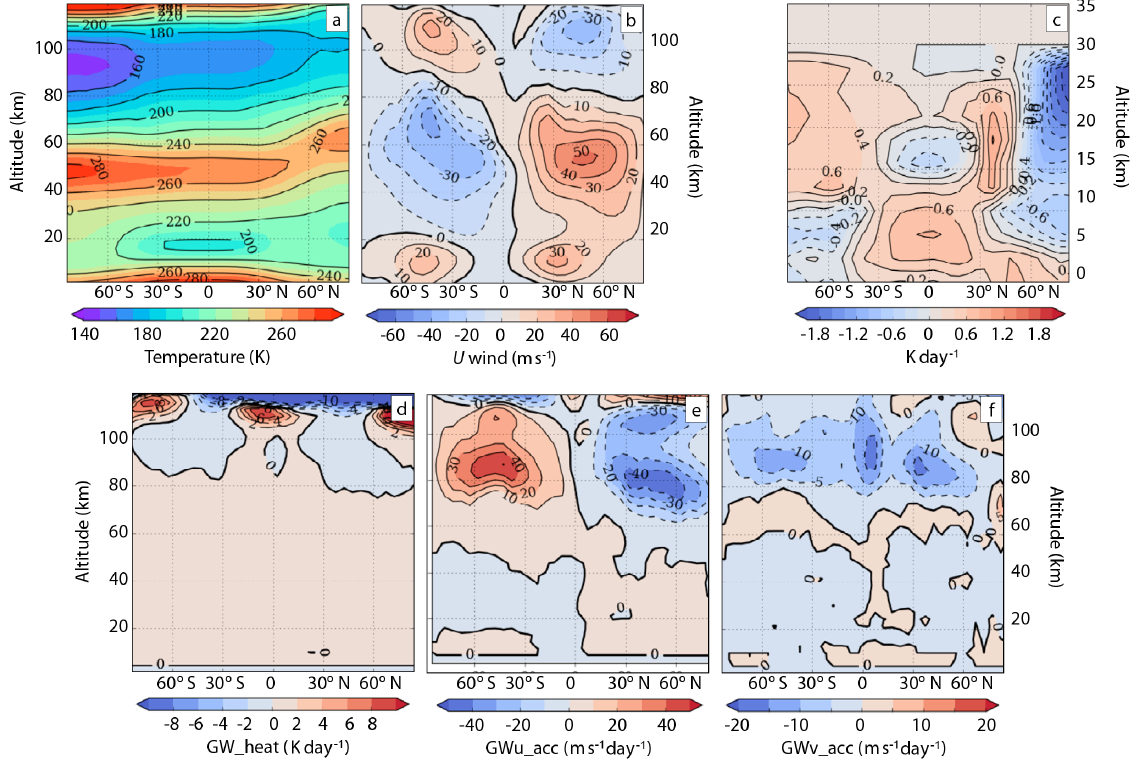
Figure 1. Mean January zonal means of temperature (a) , zonal wind (b) , GW-induced heating (d) GW-induced zonal wind acceleration (e) and meridional wind acceleration (f) for the reference simulation. Additionally, mean January zonal-mean nudging strength for the strongest GWD injection (SSWbox simulation in Table 1) is shown (c) .